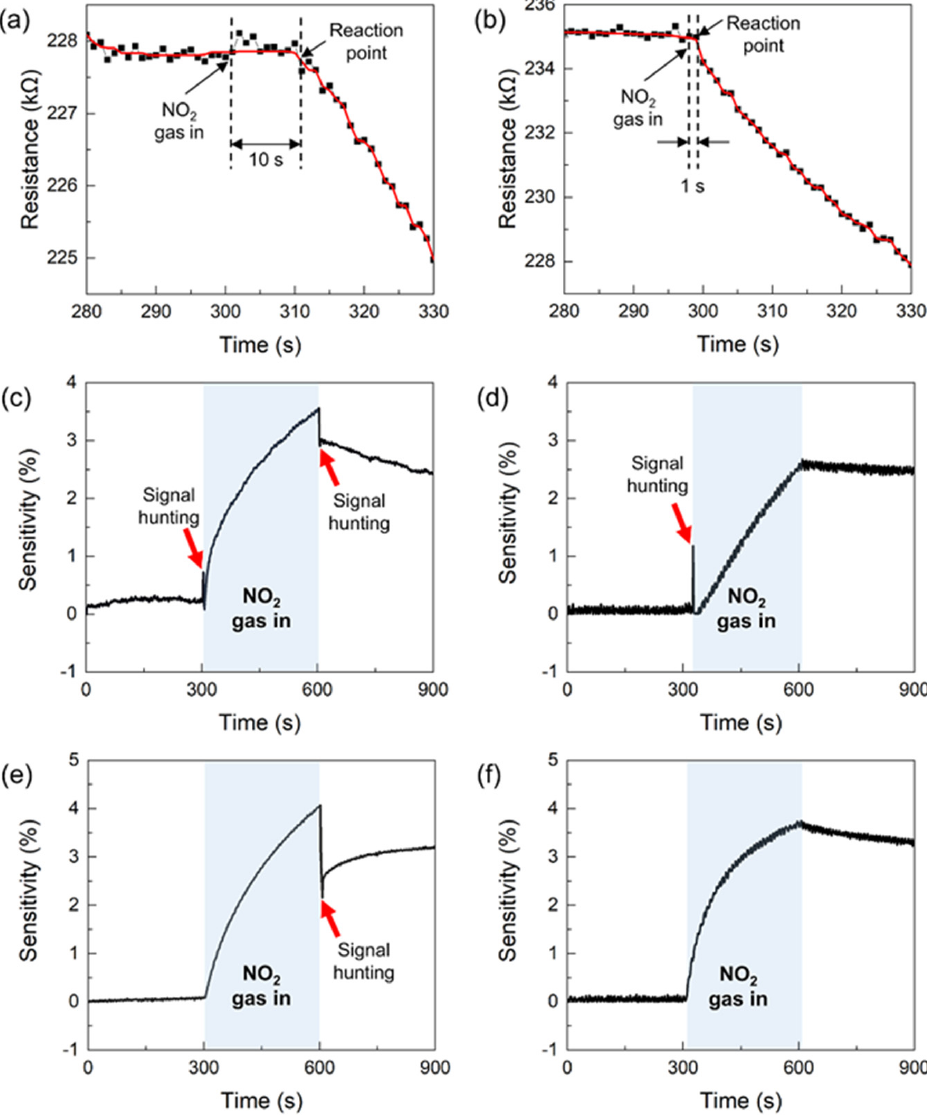
Figure 2. Changes in resistance of the MoS 2 gas sensor exposed to 5 ppm of NO 2 . ( a ) Single gas inlet (common operating sequence); delayed reaction at the point of NO 2 exposure. ( b ) Two-gas inlets (time delay on/off switching of gas inlet valve); no delayed reaction. ( c ) No time delay control (common operating sequence). ( d ) One-second time delay control applied to the recovery step. ( e ) One-second time delay control applied to the NO 2 exposure step. ( f ) One-second time delay control applied to both the NO 2 exposure and the recovery step.